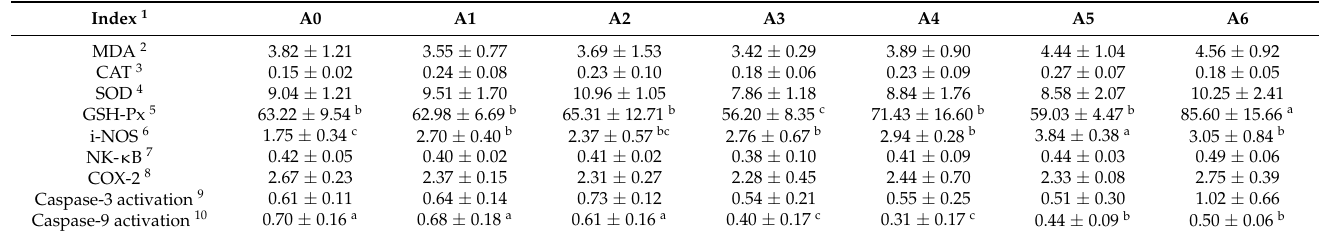
Table 5. Effects of Yarrowia lipolytica on antioxidation and immune indexes in hepatopancreas of Litopenaeus vannamei .